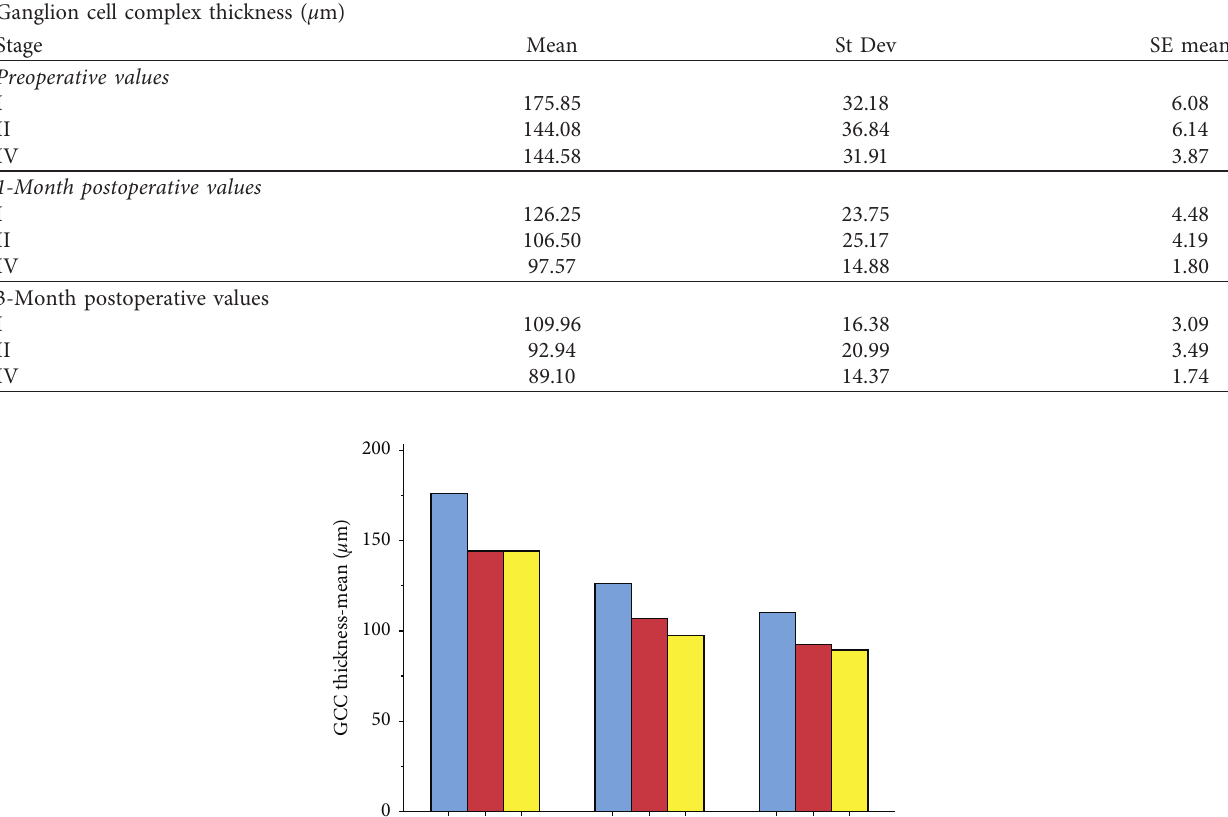
Table 4: Mean preoperative and postoperative GCC thickness values in the three groups.